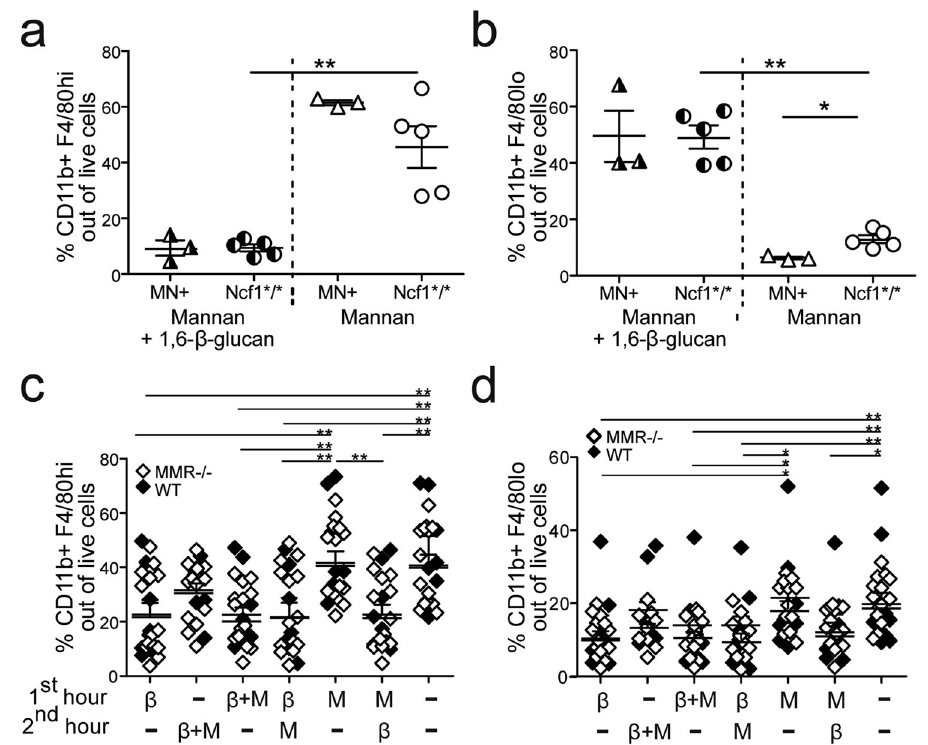
Fig. 5 1,6- β -glucan decreases the number of resident peritoneal macrophages. Resident ( a ) and in fi ltrating ( b ) macrophages were measured among live peritoneal cells collected day 8 after induction of MIP with or without co-administration of 1,6- β -glucan (2 mg) in Ncf1*/* and MN + mice. For analysis of cell phenotypes after in vitro stimulation ( c , d ), naive peritoneal cells were collected from MMR − / − and WT mice and challenged in vitro for a total of 2 h, using two different stimulation points (1 h in between), with mannan (M) and/or 1,6- β -glucan ( β ) without washes between the treatments. Resident macrophages were de fi ned as CD11b + F4/80hi (in a and c ) and in fi ltrating macrophages as CD11b + F4/80lo (in b and d ), as determined by fl ow cytometry. Data in ( c , d ) are a combination of two experiments with total n = 21. Statistical analyses were performed with Mann – Whitney test ( a, b ) and one-way ANOVA using Bonferroni post test ( c , d ). * P < 0.05; and ** P < 0.01. Results are presented as mean with